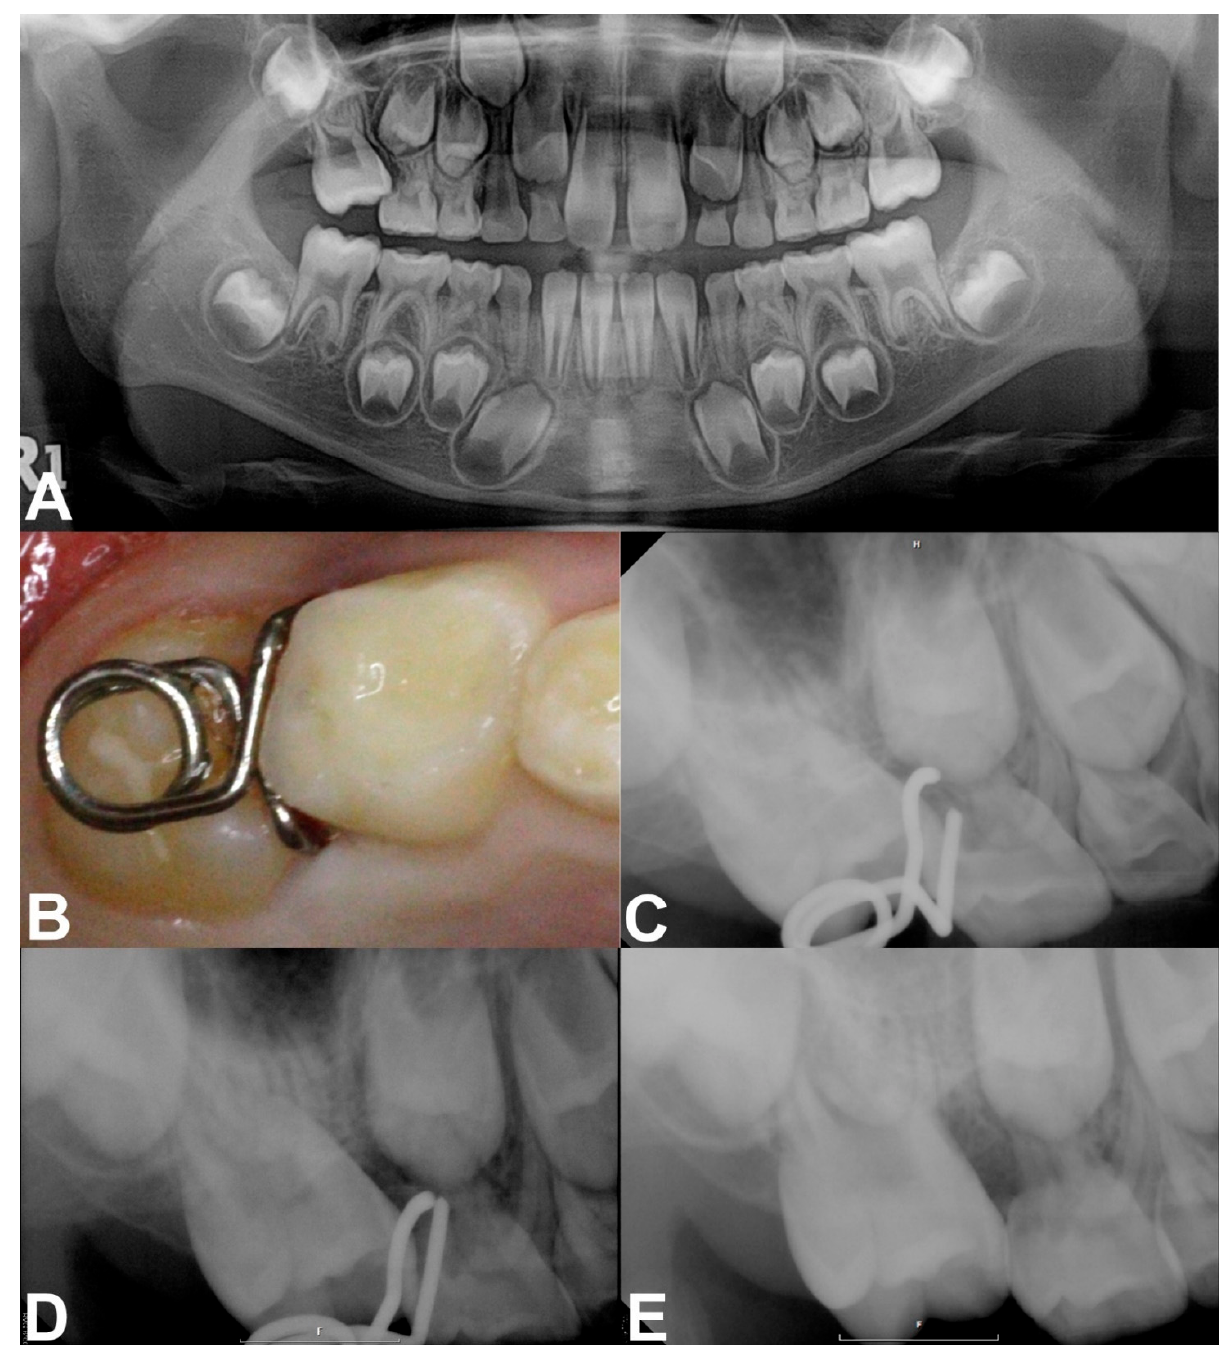
Figure 3. Pre-treatment and treatment progress images of case 2. ( A ) Panoramic radiograph revealed the ectopic eruption of the right maxillary first molar. ( B , C ) Intraoral photograph and periapical radiograph after insertion of the mRS. ( D ) Periapical radiograph obtained at the 1-month checkup. ( E ) 3 months after treatment showing a corrected right maxillary first molar.